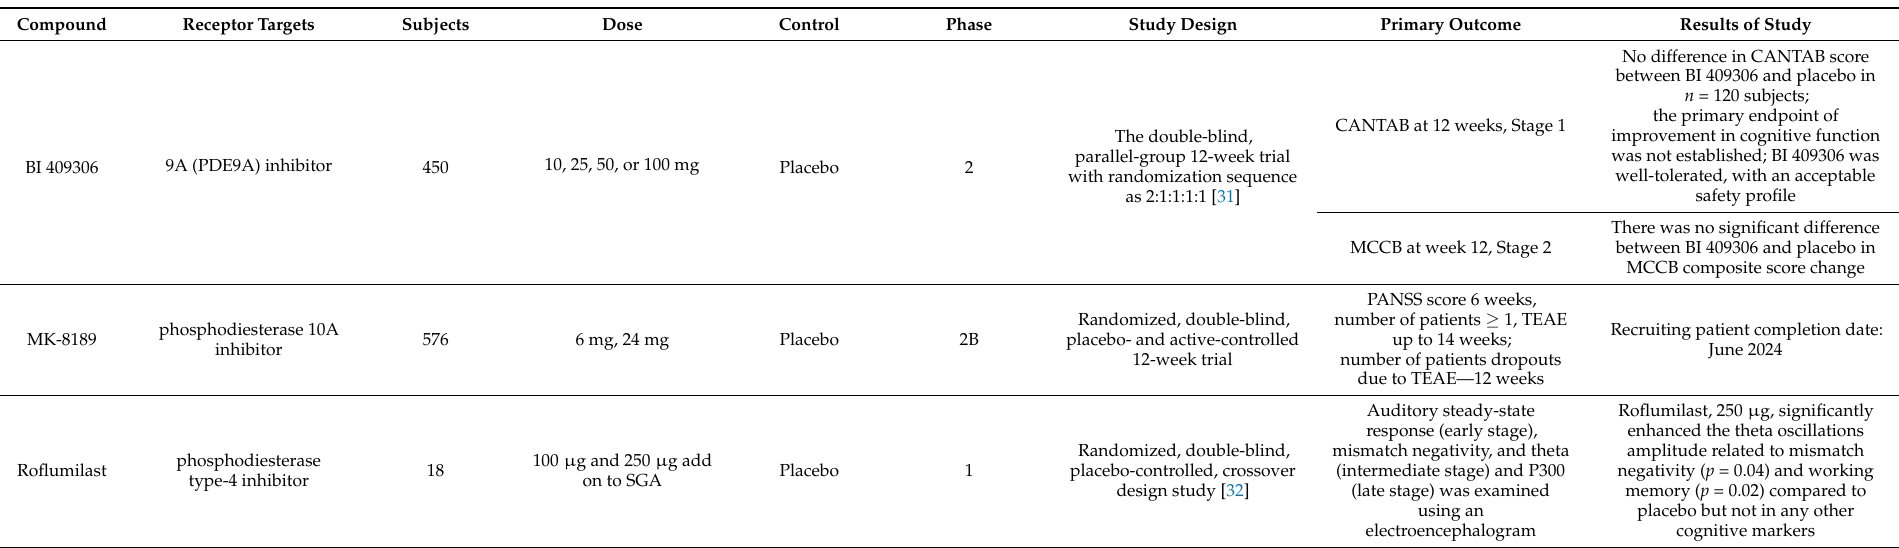
Table 3. Modulators of